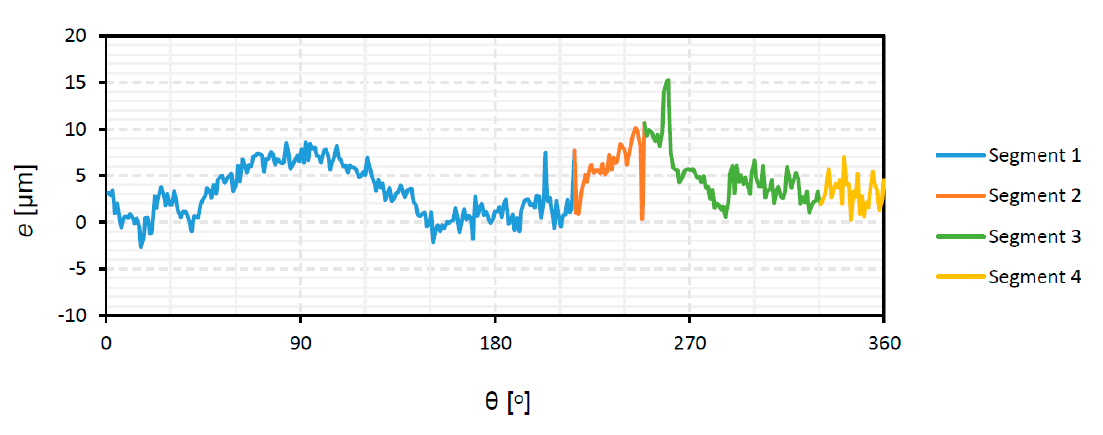
Figure 15. Shape error of the milled cam.